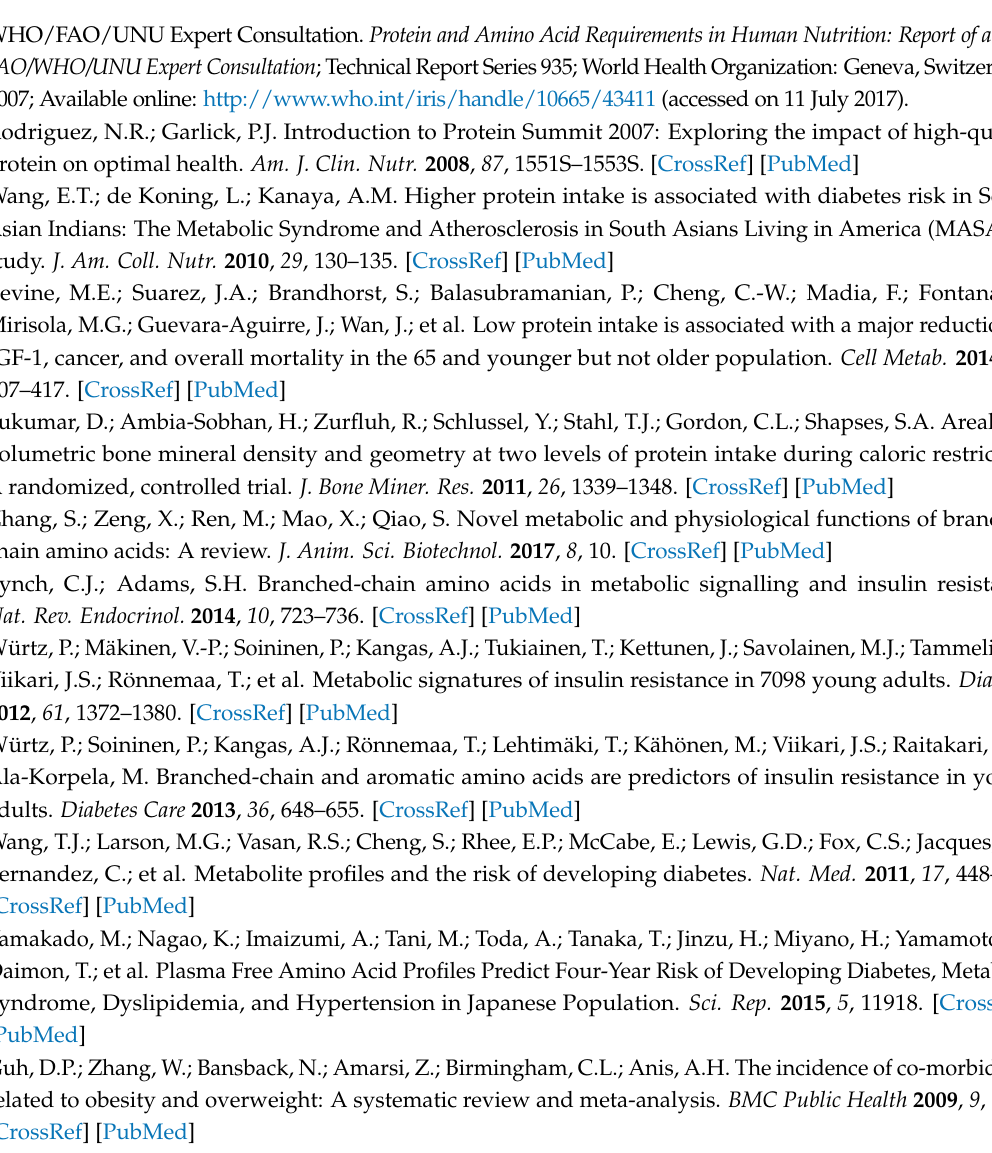
Table S1: Plasma concentrations of amino acids by dairy intake groups throughout the intervention